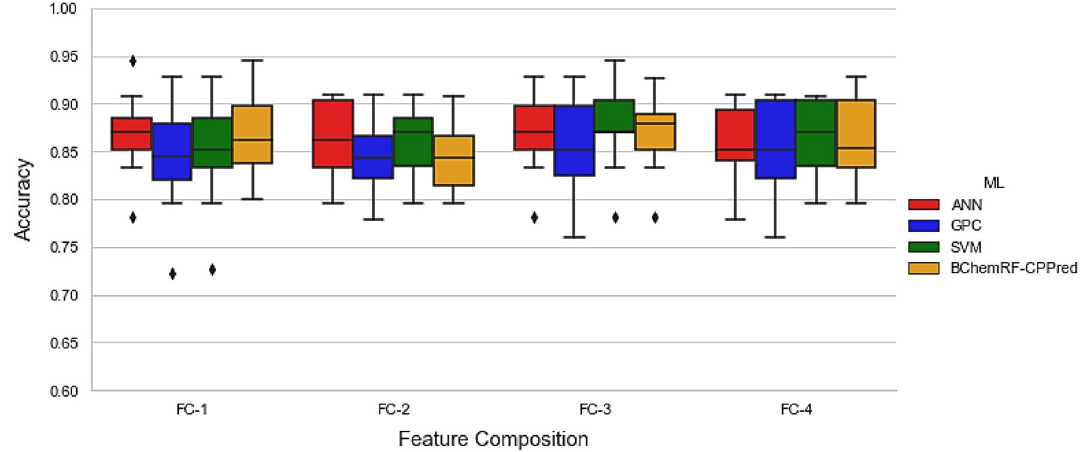
Figure 3. Boxplot of accuracy from tenfold cross-validation of ANN (red), GPC (blue), SVM (green), and BChemRF-CPPred (orange) using FASTA